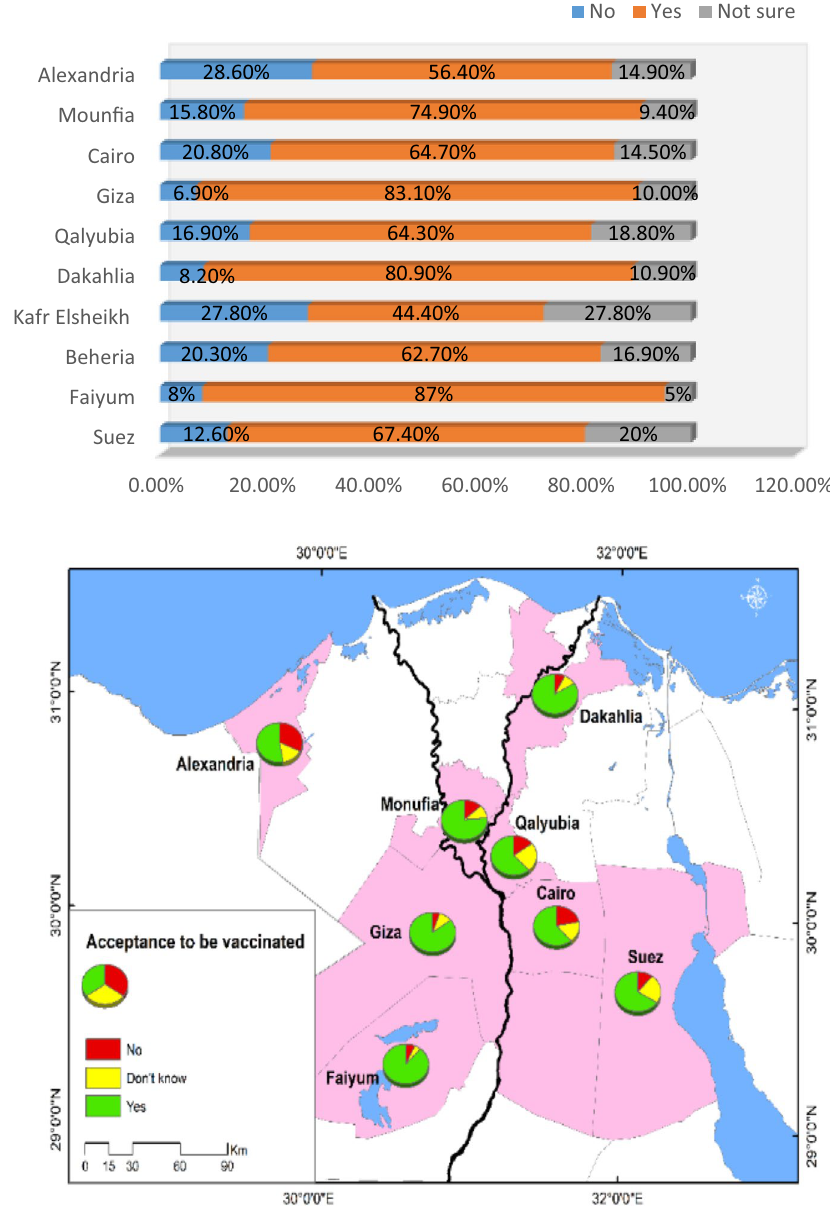
Figure 3. Vaccine acceptance in different Egyptian